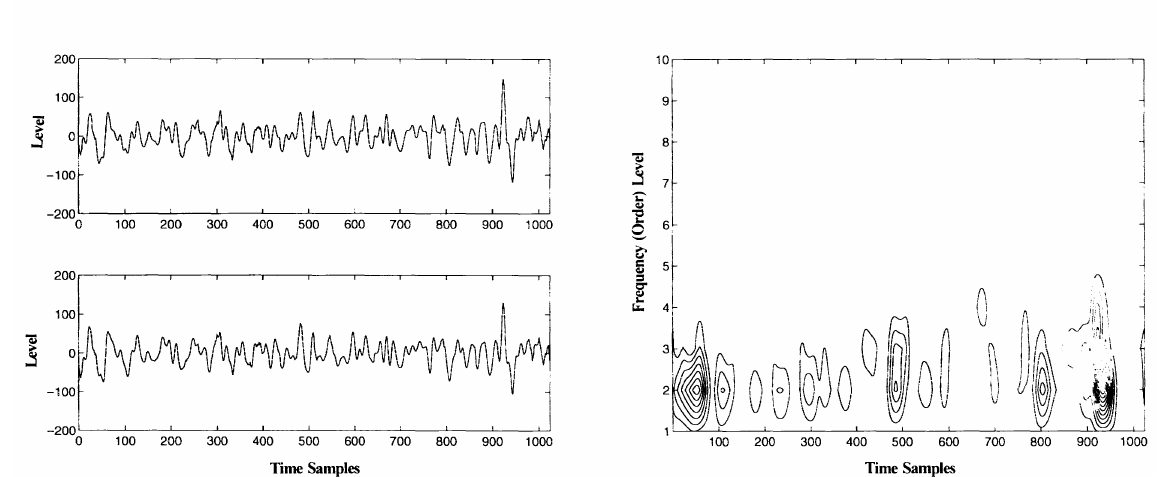
FIGURE 8 Square of time-frequency distribution (faulty